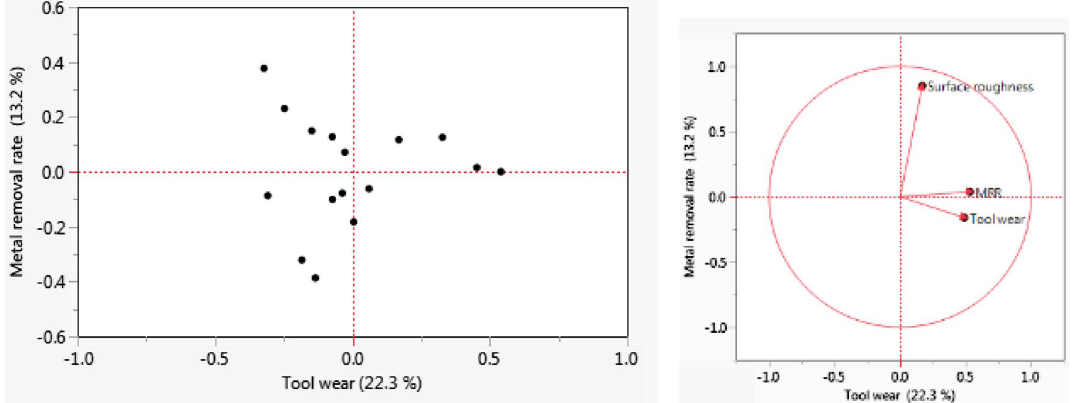
Fig. 9 Accountability proportion (AP) values of tool wear vs. metal removal